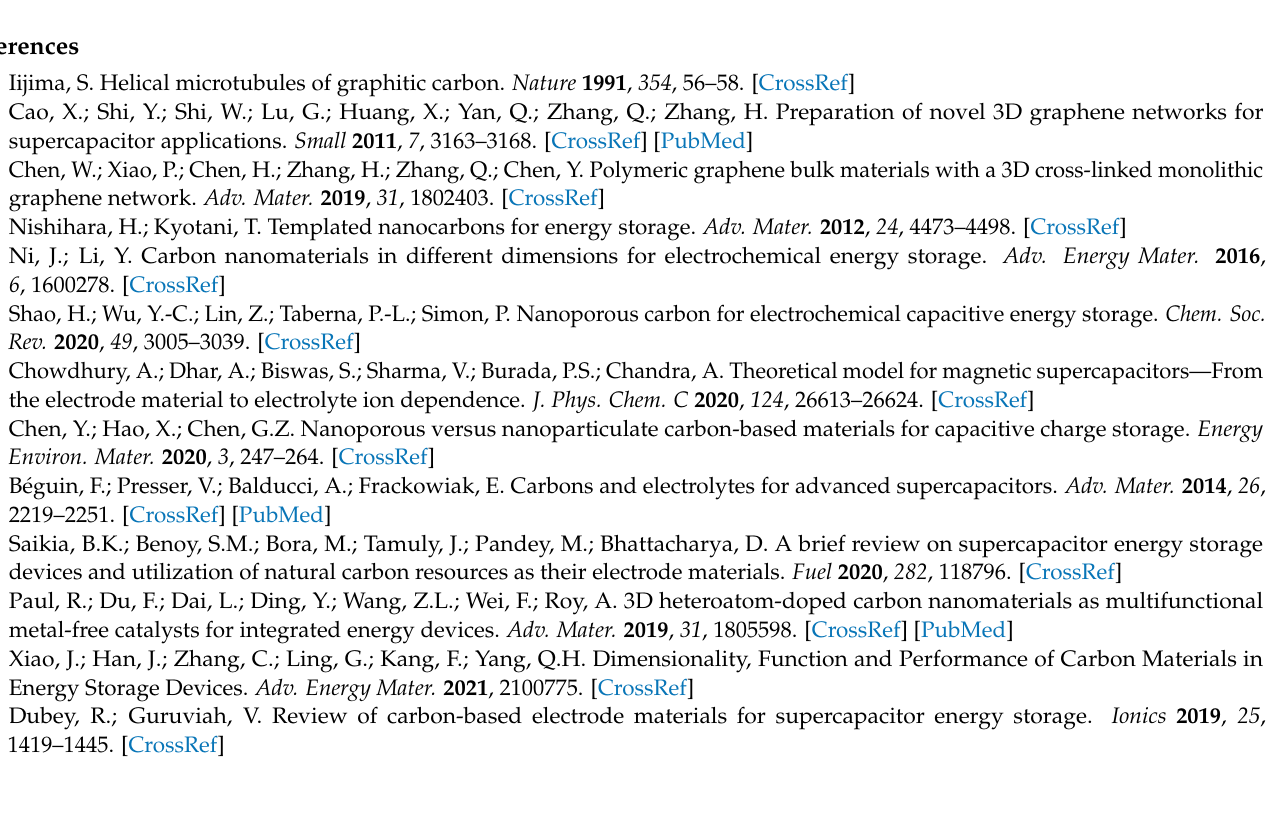
different samples, Figure S3: XRD pattern of samples. Figure S4: Equivalent series resistance (ESR) of cells assembled with each sample, Figure S5: Cycle stability for samples at 5 mA · cm − 2 and 1–2.7 V. Figure S6: Charge-discharge profiles, Table S1: Surface contents in samples and curve fitting results of the XPS C1s spectra, Table S2: Electrode density of